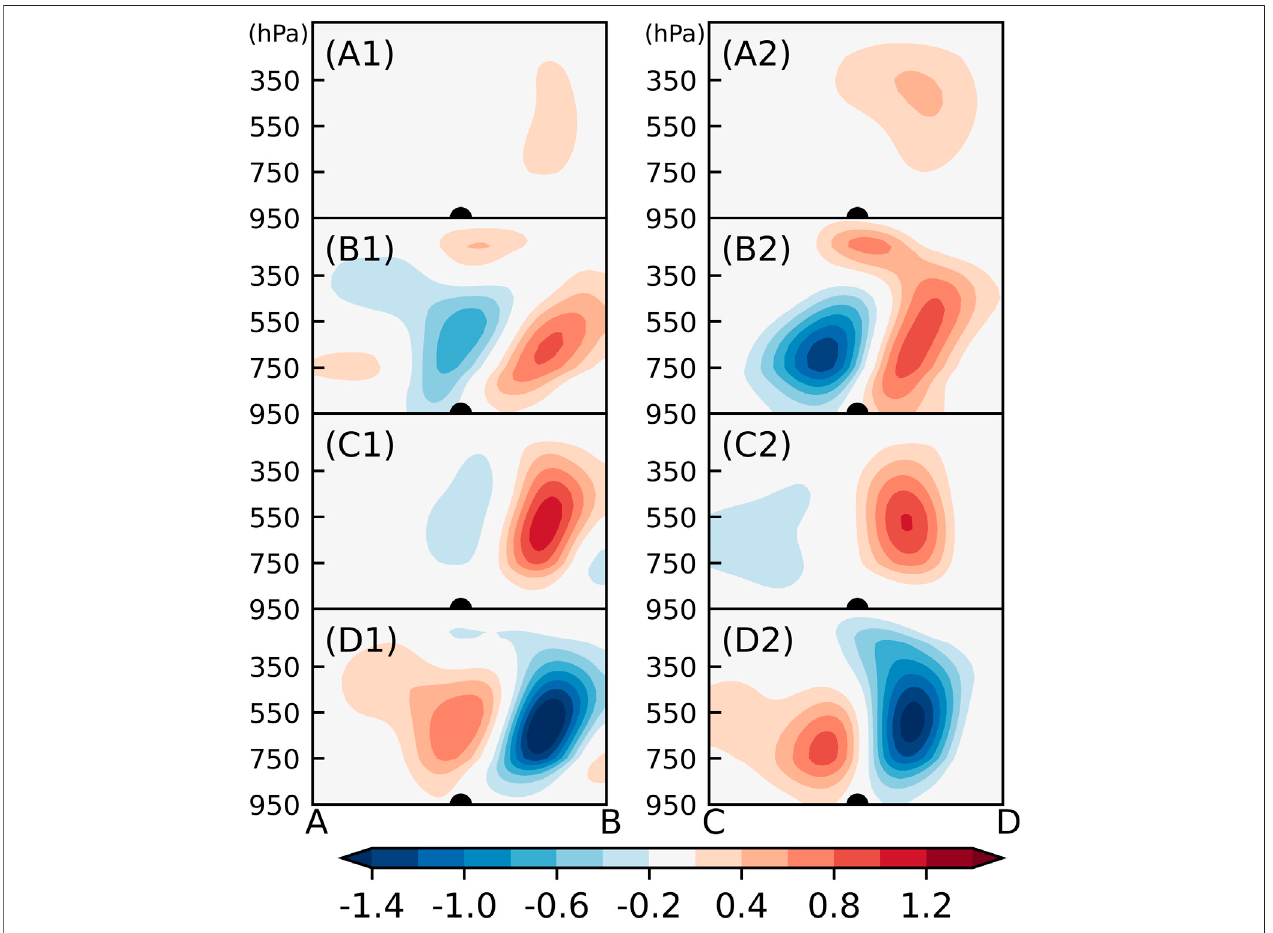
FIGURE 7 | Vertical cross sections of the cyclonic-vorticity advection [ (A1, A2) , 0.2 × 10 − 9 s − 2 intervals], warm-air advection [ (B1, B2) , 0.2 × 10 − 9 s − 2 intervals], diabaticheating [ (C1, C2) ,0.2 × 10 − 9 s − 2 intervals]and adiabaticheating[ (D1,D2) , 0.2 × 10 − 9 s − 2 intervals] along thelines A – Band C – Dasillustratedin Panel 5 (green lines) .ThelinesareselectedtopassthroughtheSECcenterandthetotaltendencycenter. A: (27.25 ° N,83.5 ° W), B: (34.25 ° N,66.5 ° W), C: (29.5 ° N,71.5 ° W), D: (43.5 ° N, 64.5 ° W). (A1 – D1) 18 UTC 25, (A2 – D2) 06 UTC March 26, 2014. The large solid dot denotes the SEC center.